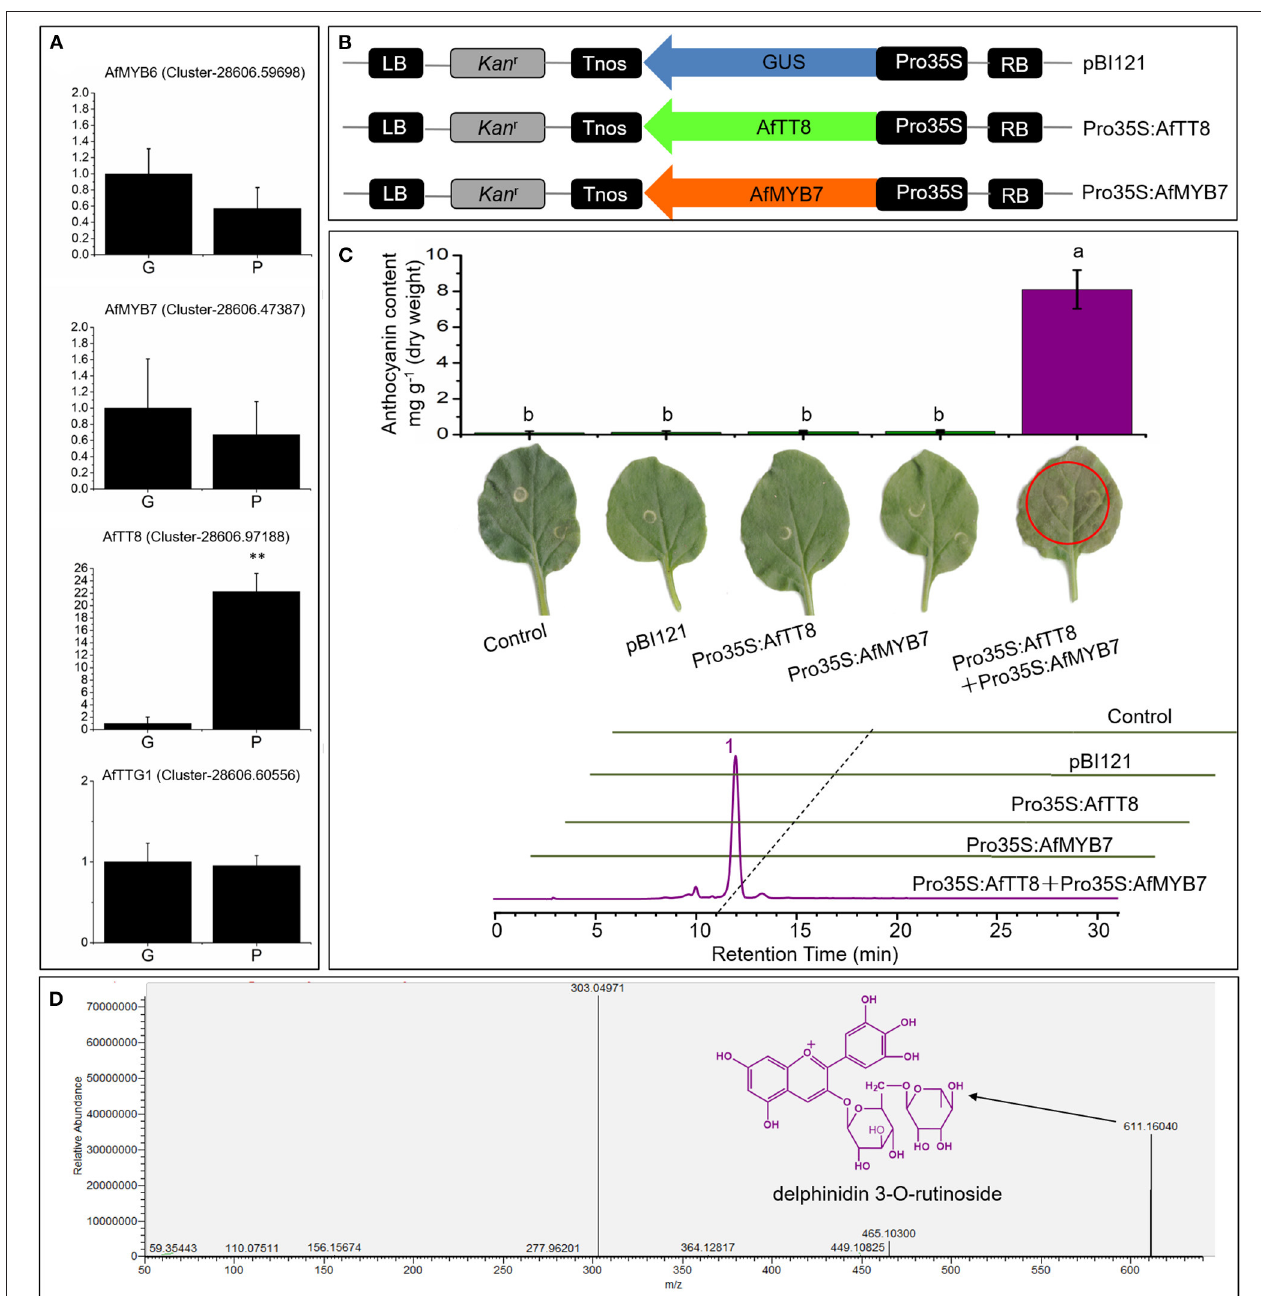
FIGURE 5 | AfTT8 and R2R3-MYB protein AfMYB7 coordinately trigger anthocyanin accumulation in Nicotiana benthamiana . (A) Expression analysis of anthocyanin biosynthesis regulatory genes in leaves of different fennel varieties. (B) Schematic representation of the expression vectors. (C) Anthocyanin pigmentation and anthocyanin contents in Nicotiana benthamiana leaves (up) and HPLC profiles of anthocyanins extracted from infiltrated patches 4 days after infiltration (down). (D) MS 2 spectra of the major anthocyanin [corresponding to peak 1 in the chromatogram of (C) ] identified in infiltrated leaves and the structure was indicated with black arrow. Triplicate biological replicates were conducted and different letters represent significance at p < 0.05. G and P indicate the green and purple fennel variety, respectively.